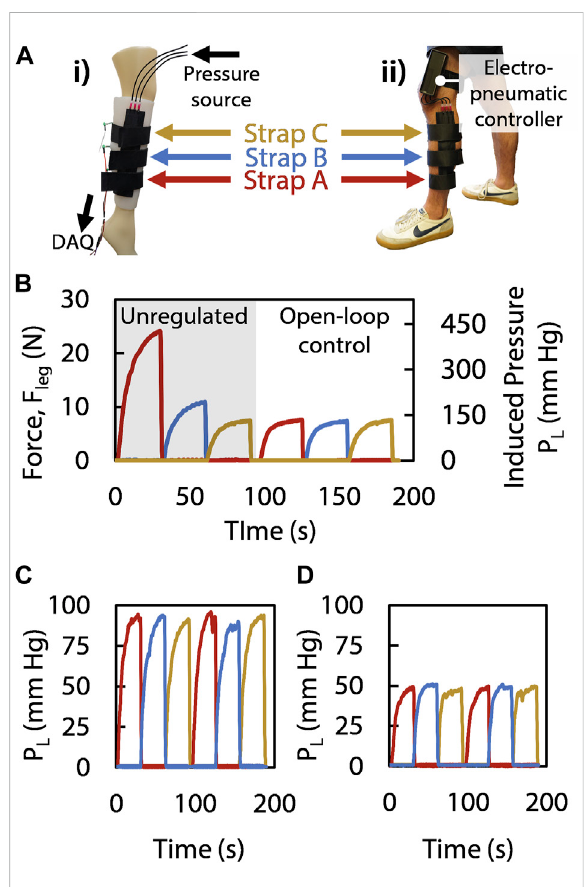
FIGURE 4 (Ai) The mannequin leg wears the SCT device, with a sensor measuring the F leg between the leg and the Dragon Skin elastomer; (Aii) the same setup is attached to human leg with a thigh-mounted electropneumatic controller containing the micropump, solenoid valves, and microcontroller. (B) In the unregulated regime, all three straps pressurize to the same P pouch , and strap A (wrapped around a portion of the leg that has a smaller diameter) exerts signi fi cantly greater F leg , which agrees with the Laplace force model in Eq. 5. Under open-loop control, the duty cyclecontrolsallthreestrapswithdifferentmagnitudesofP pouch in correspondence with their particular diameters, thereby producing the same F leg along theleg. (C) All straps exert the same P L with regulated duty cycles, achieving nearly 100 mm Hg on the mannequin. (D) The device delivers SCT on the human leg at 50 mm Hg, falling within the suggested range of pressures of 40 – 120 mm Hg (Zaleska et al.,